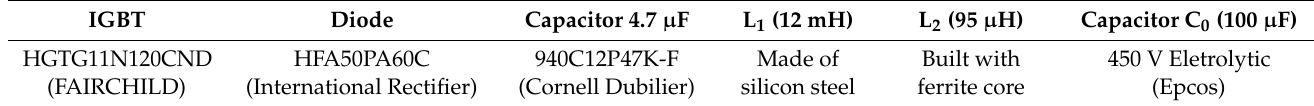
Figure 10. SEPIC-type 1 kW workbench. Table 3. Commercial components used on the workbench.